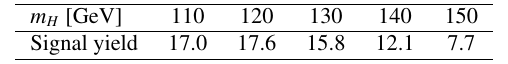
Fig. 2. Diphoton, photon-jet, dijet and Drell-Yan contributions to the diphoton candidate invariant mass distribution. The various components are stacked on top of each other. The error bars cor- respond to the uncertainties on each component separately. Table 1. Yields of Higgs signal at the MC generated mass